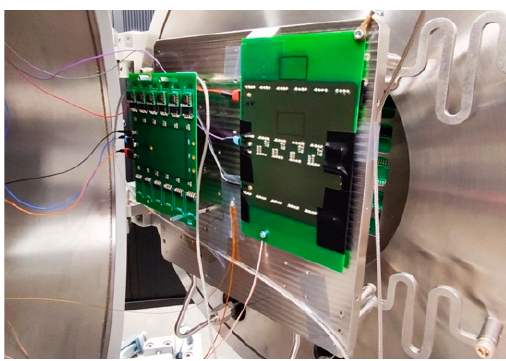
Figure 1. The sample holder inside the thermal vacuum radiation chamber, which was developed at the National Accelerator Centre (CAN) in Spain.